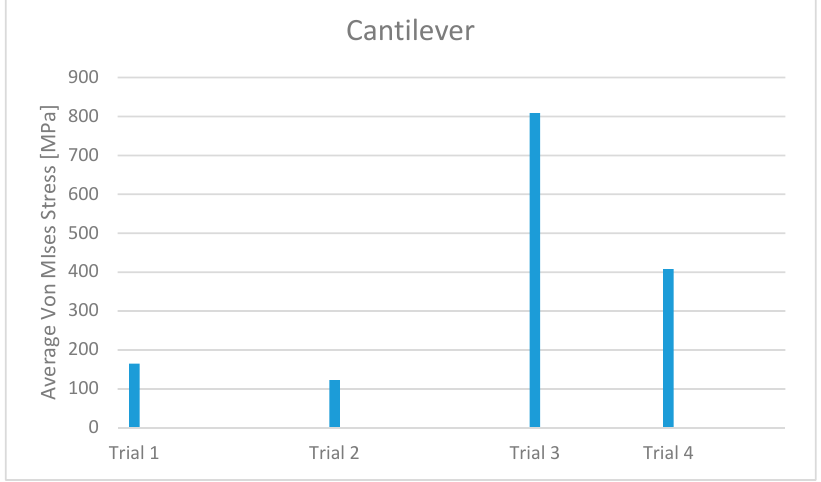
Figure 14. Cantilever stress maximum value for each trial and for the different zones.